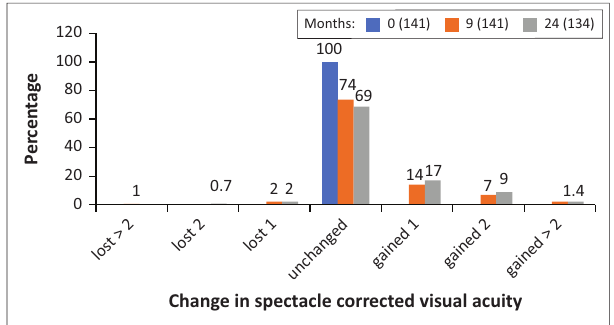
FIGURE 1: Safety in term of loss and gain in best spectacle corrected visual acuity at 0, 9 and 24